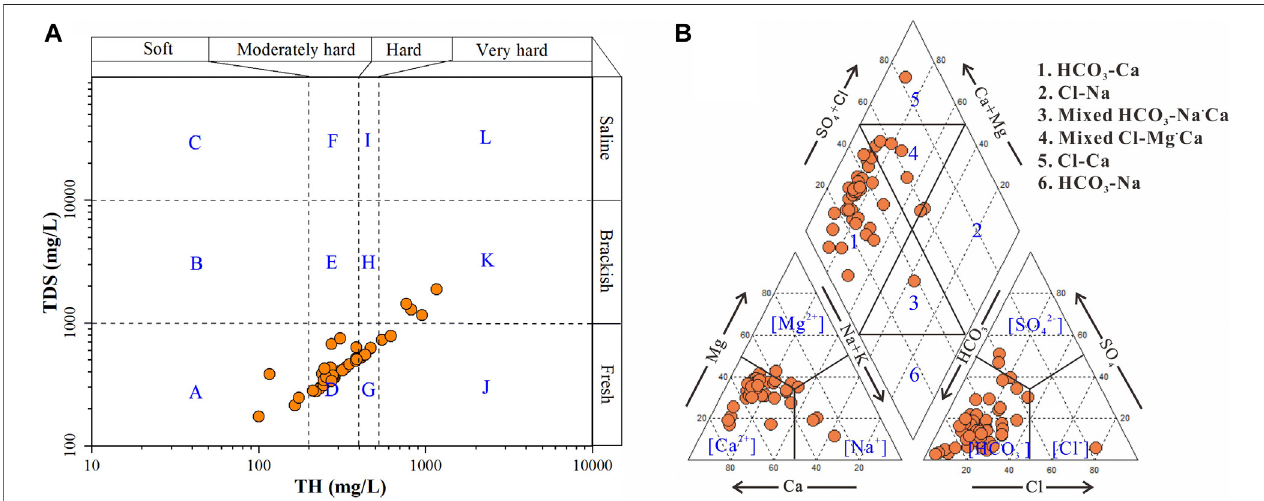
FIGURE 2 | Scatter plots of (A) TH versus TDS, and (B) Piper diagram for groundwater